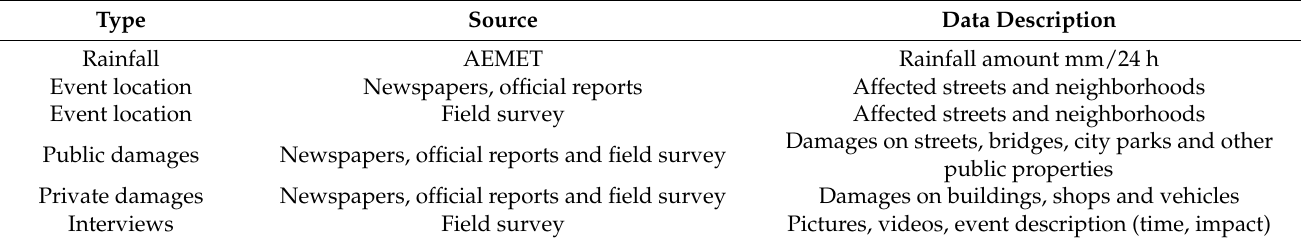
Table 3. Sources of